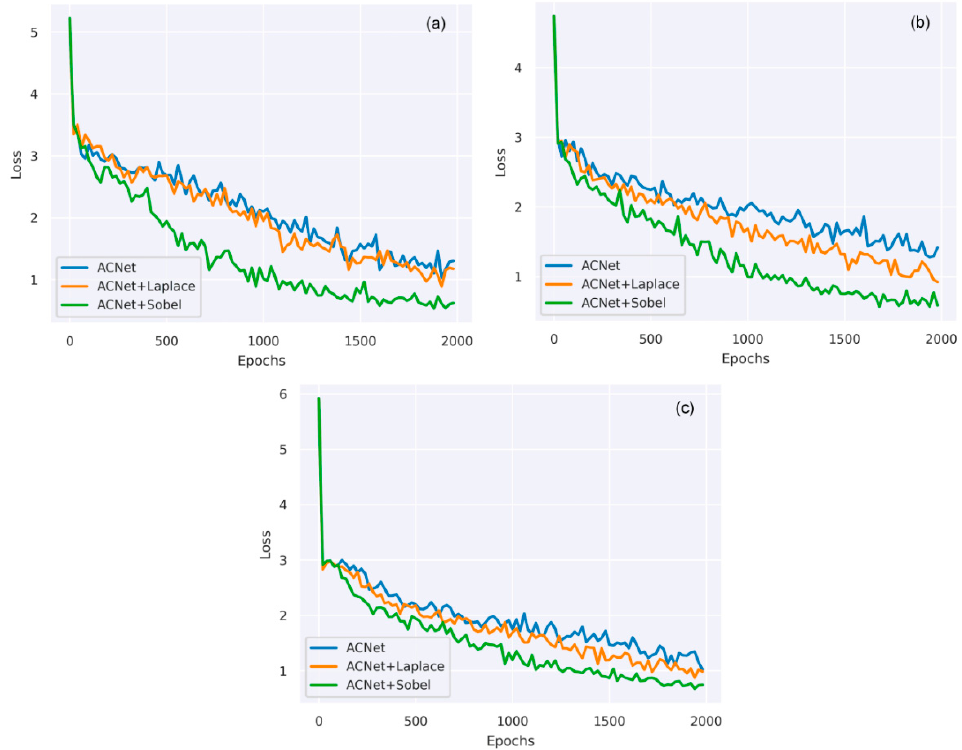
Figure 9. Training loss with different edge detection filters. ( a – c ) Experiment area 1, 2, and 3, respec- tively.